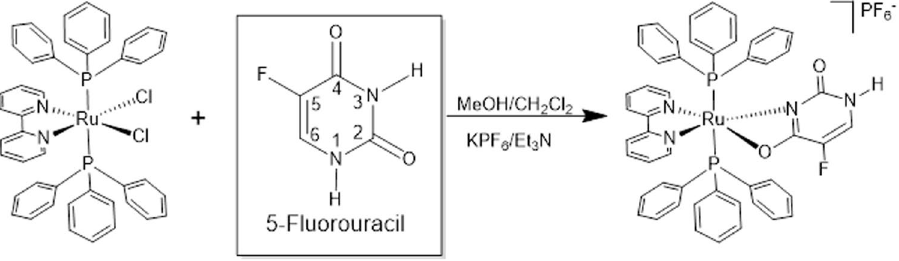
Figure 1. Synthetic route to obtain the complex [Ru(5-FU)(PPh 3 ) 2 (bipy)]PF 6